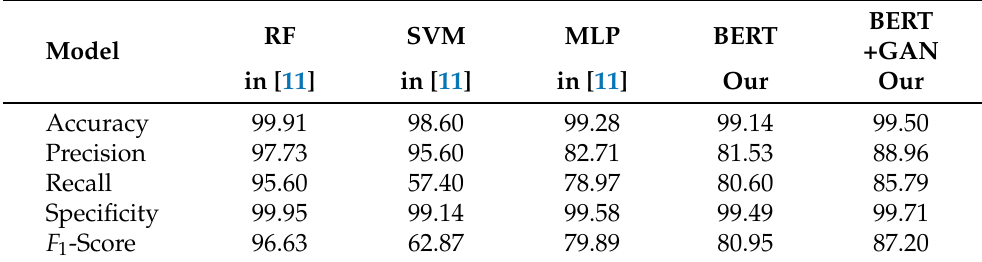
Table 6. Comparison between our proposal and the activity recognition models implemented in [11] for the UP-FALL dataset and sliding windows using skeletons.